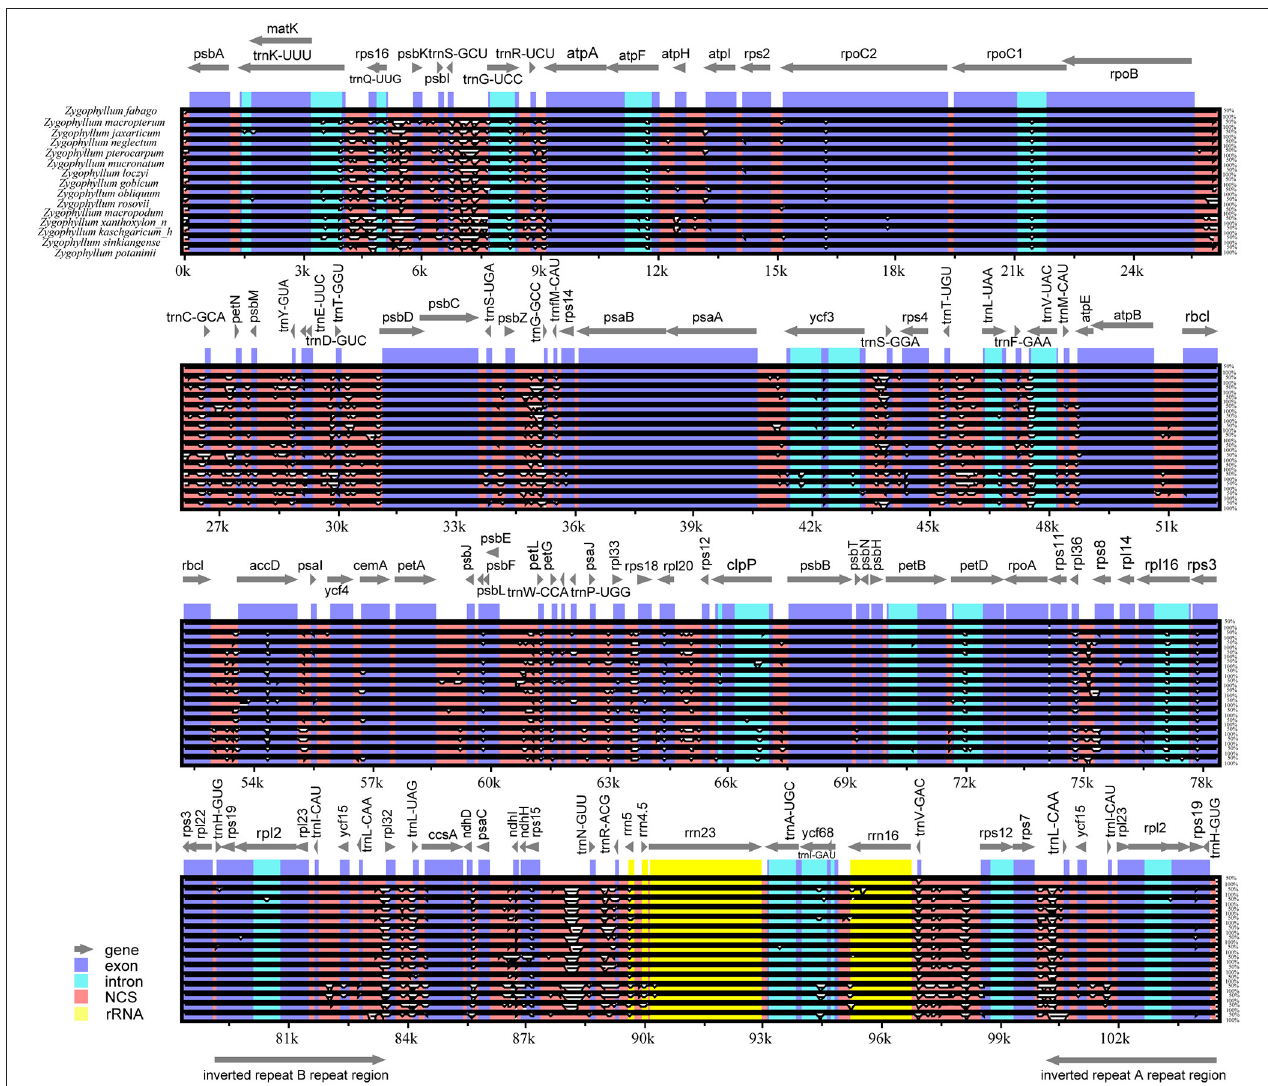
FIGURE 3 | Comparison of plastomes of 15 species of Zygophyllum using Z. fabago as reference. Gray arrows and thick black lines above the alignment indicate gene orientation. Exons and introns are shown in blue (dark and light, respectively). Other intergenic spacers are shown in red. Ribosomal RNA genes are indicated in yellow. The y -axis indicates the percentage of identity, ranging from 50% to